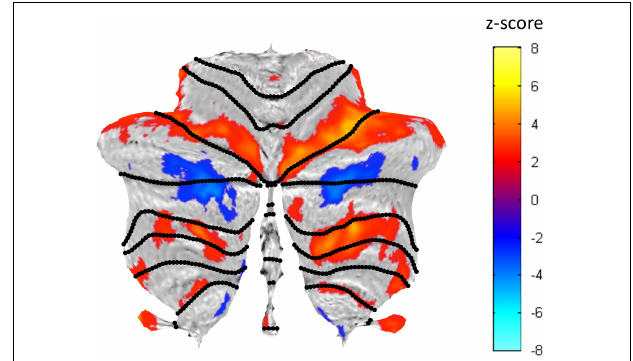
FIGURE 5 | Cerebellar flatmap representation of the average activation across the three Visualization repeats, thresholded at z-score of ± 0.5. Positive BOLD activation coded in warm colors and negative BOLD activation in cool colors. The regions of activated voxels within each lobule were used to define the ROIs for further analysis.